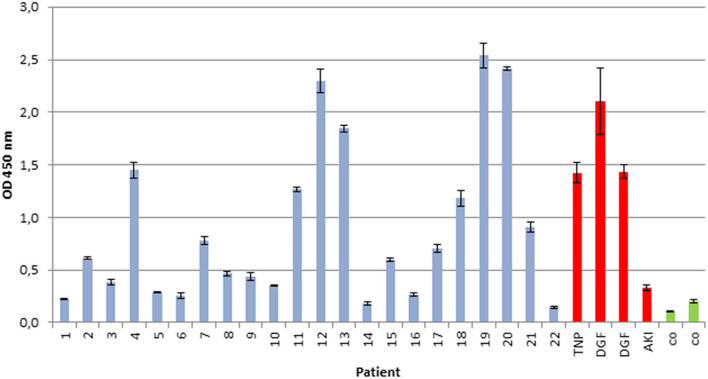
Immunoglobulin/LC binding to immobilized renal whole-cell lysate. Urine of 22 patients with multiple myeloma and plasma cell dyscrasia was incubated in ELISA plates, coated with whole-cell renal lysate, and compared with urine of four patients with renal reperfusion injury (DGF, delayed graft function, red), transplant nephropathy (TNP, red), acute kidney injury (AKI, red), and two healthy controls (CO, green). All experiments were carried out in triplicates. Demographics of patients with multiple myeloma or plasma cell dyscrasia are given in Table 1.